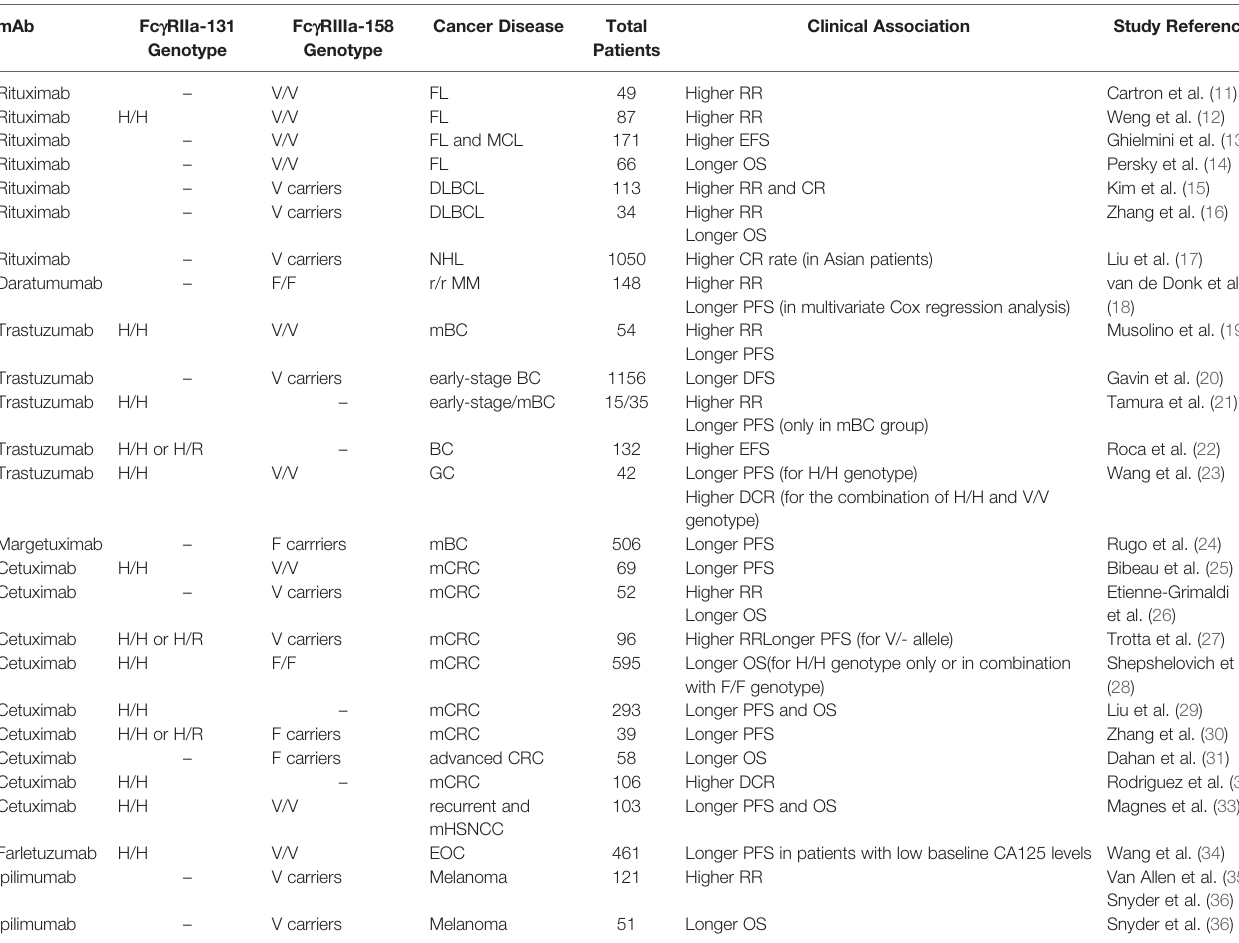
TABLE 1 | Associations between the Fc g RIIa and Fc g RIIIa polymorphisms and clinical bene fi t.